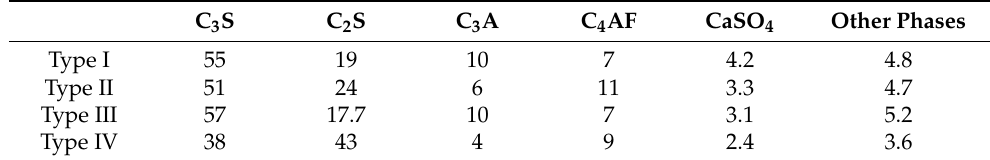
Table 1. Composition of PC (expressed in mass